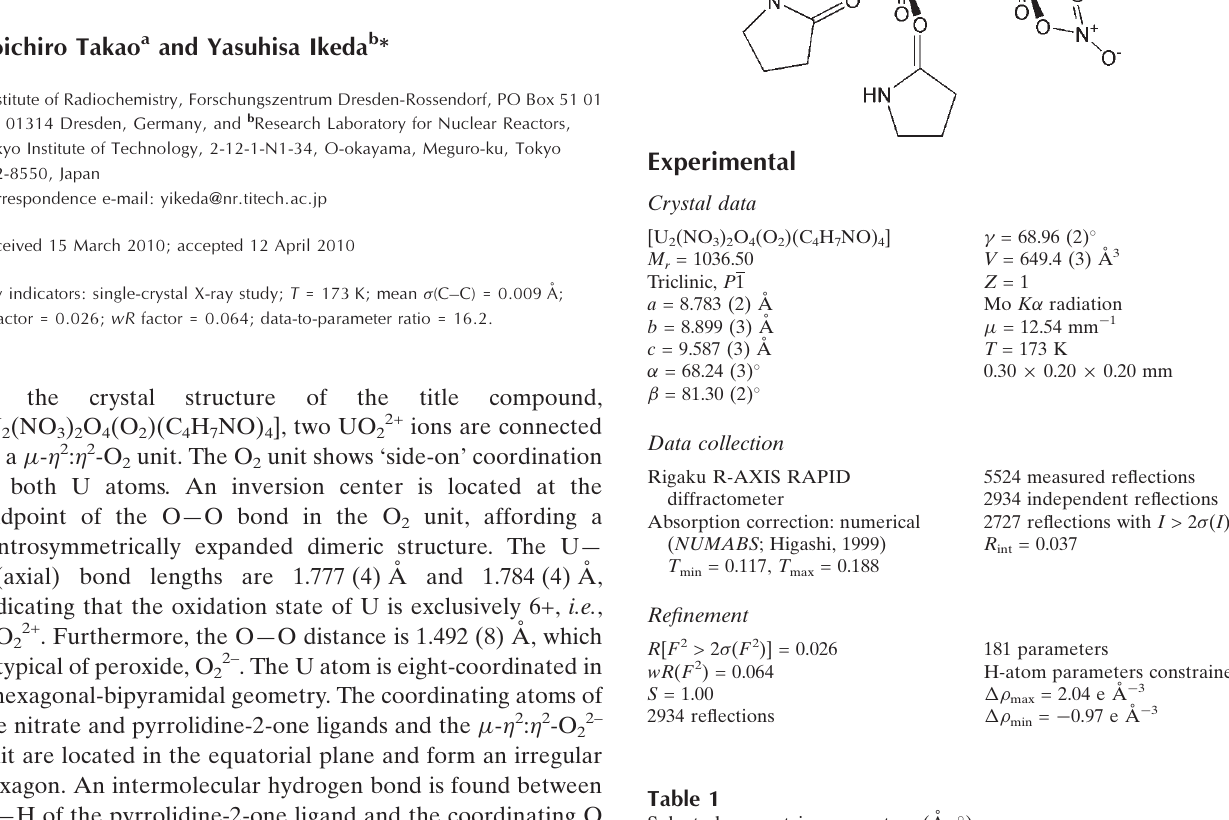
Experimental Crystal data